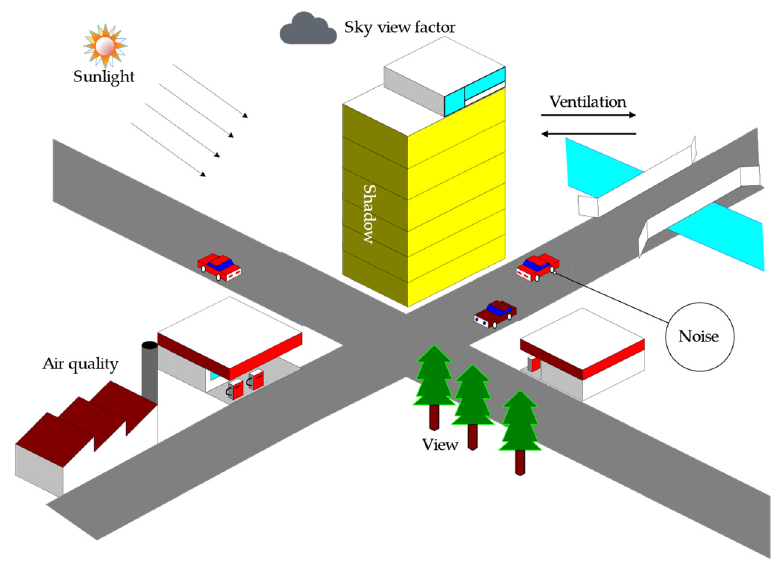
Figure 1. 3D environmental scenario.